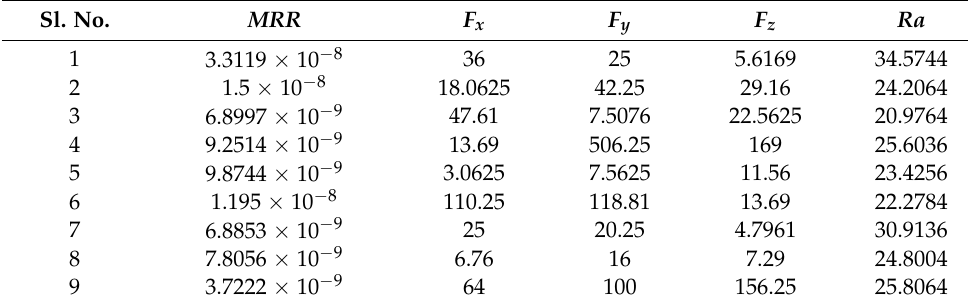
Table 6. Quality Loss ( Q ij ).